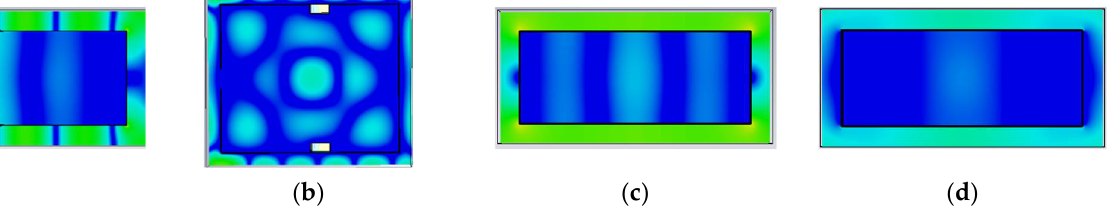
Figure 11. Mode303 field distribution of inductive obstacles with a finite thickness. ( a ) x section, ( b ) y